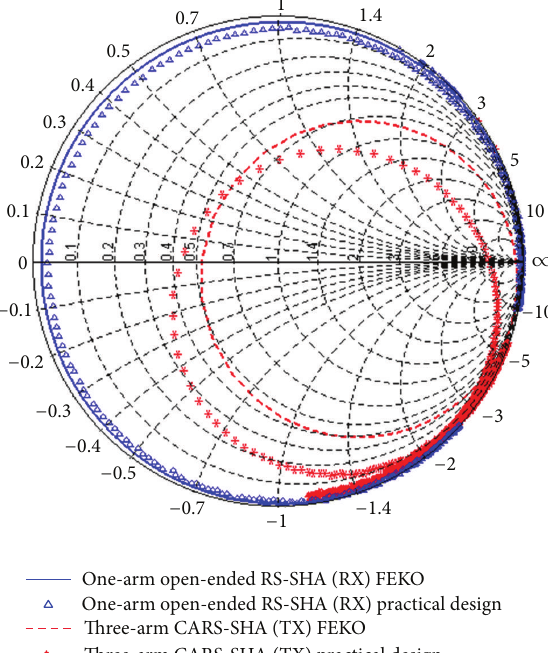
Figure 11: The 50 Ω Smith chart: standalone SHAs measurements.